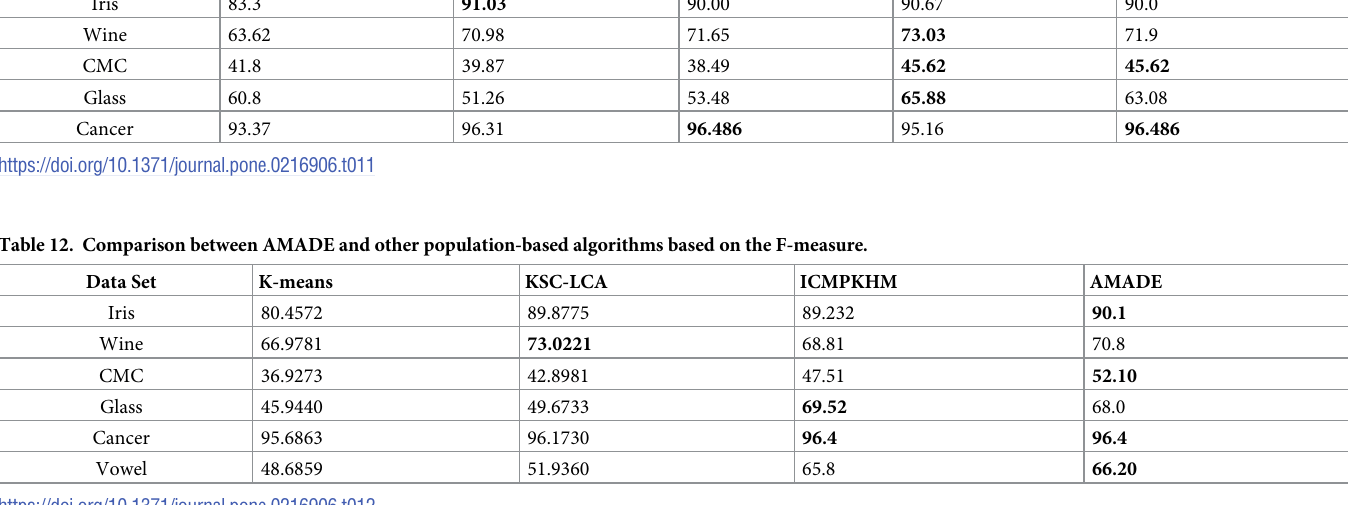
Table 11. Comparison between AMADE and other population-based algorithms based on accuracy. Data Set K-means Iris